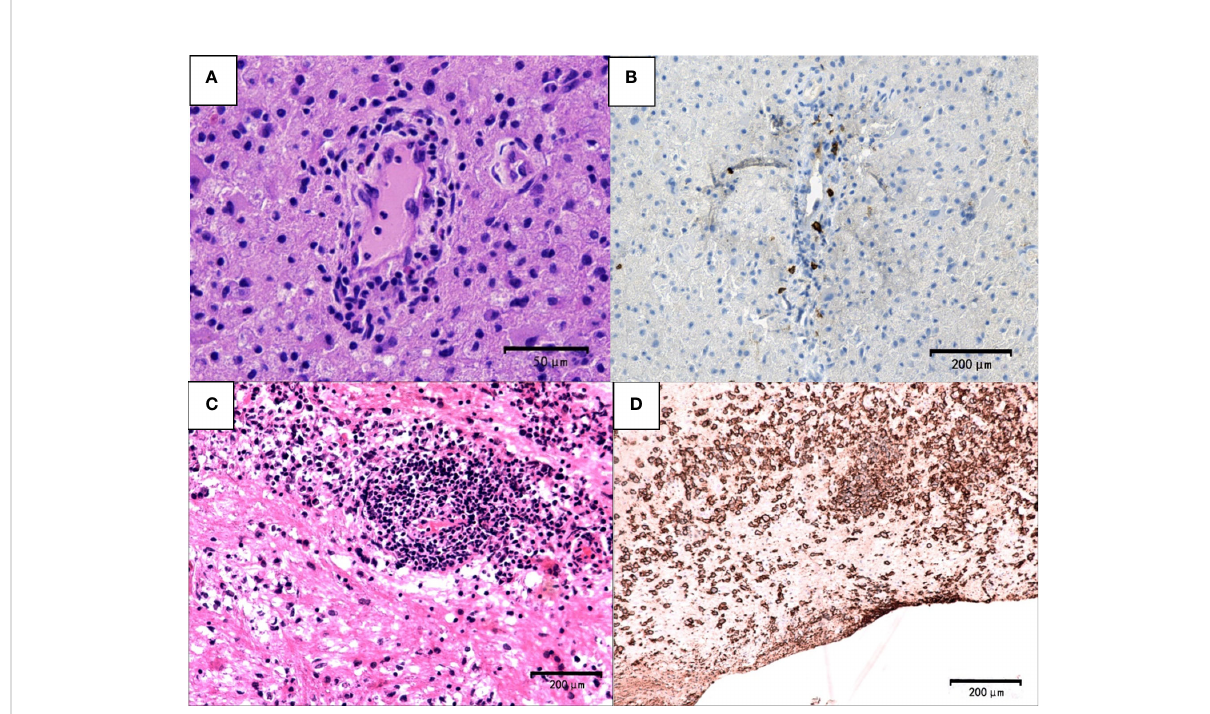
FIGURE 5 Pathological features of PCNSL. The fi rst biopsy (A, B) . (A) demyelinated lesions as well as perivascular and parenchymal in fi ltration mainly composed lymphocytes (hematoxylin and eosin, scale bar =50 m m). (B) CD20-negative cells (CD20, scale bar =200 m m). The third biopsy (C) atypical lymphocyte in fi ltration around blood vessels (hematoxylin and eosin; scale bar=200 m m) (D) CD20 + B lymphocytes and typical tumor cells (CD20; scale bar =200 m